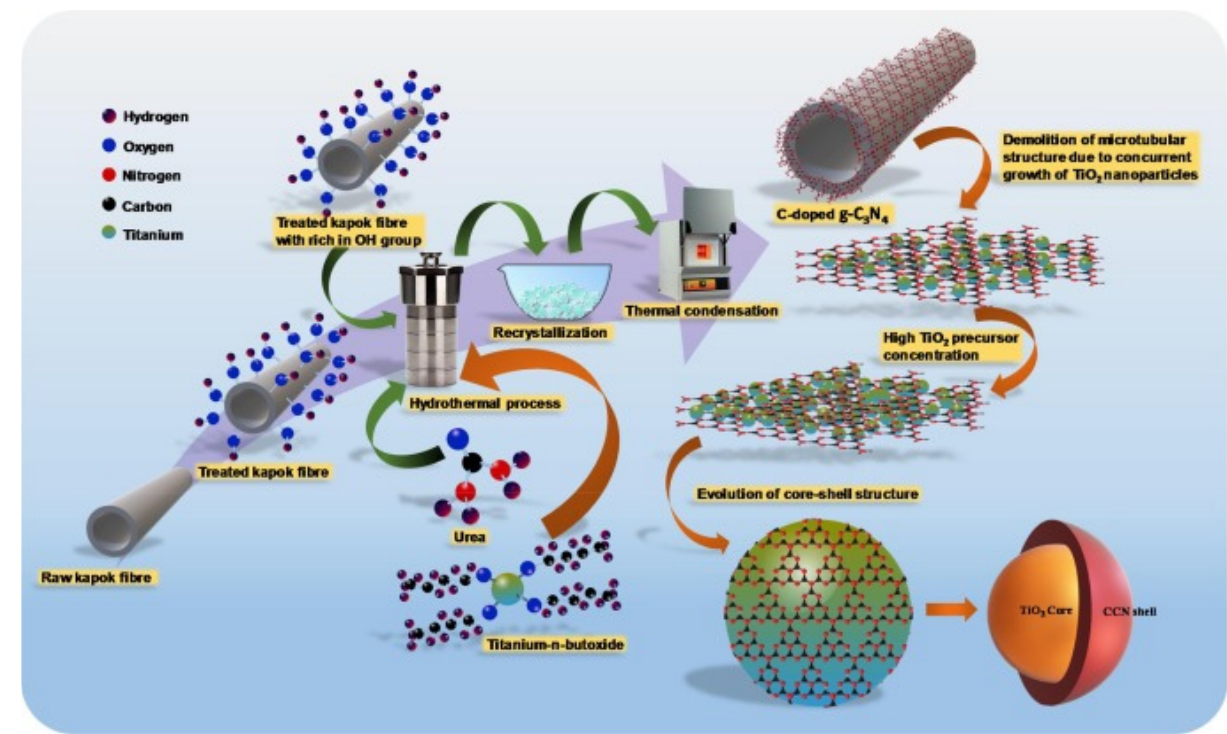
Figure 12. The production of KF-doped g-C 3 N 4 /C, N co-doped TiO 2 heterojunction photocatalysts and the development of their core-shell nanostructures are depicted schematically. Reprinted with permission from Ref. [123]. Copyright 2019, copyright